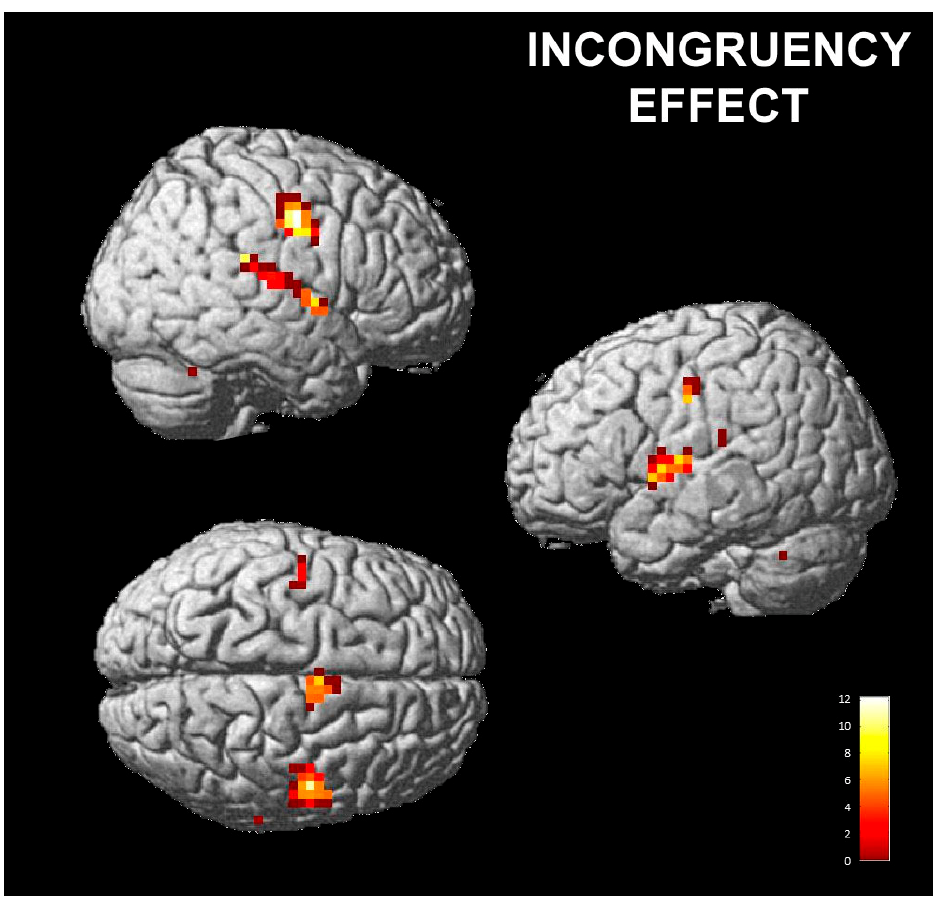
Figure 3. Incongruent pose vs. neutral pose one-sample t-test; p < 0.05, FWE corrected. Functional results are shown on the SPM12 template; color bars represent T-values.